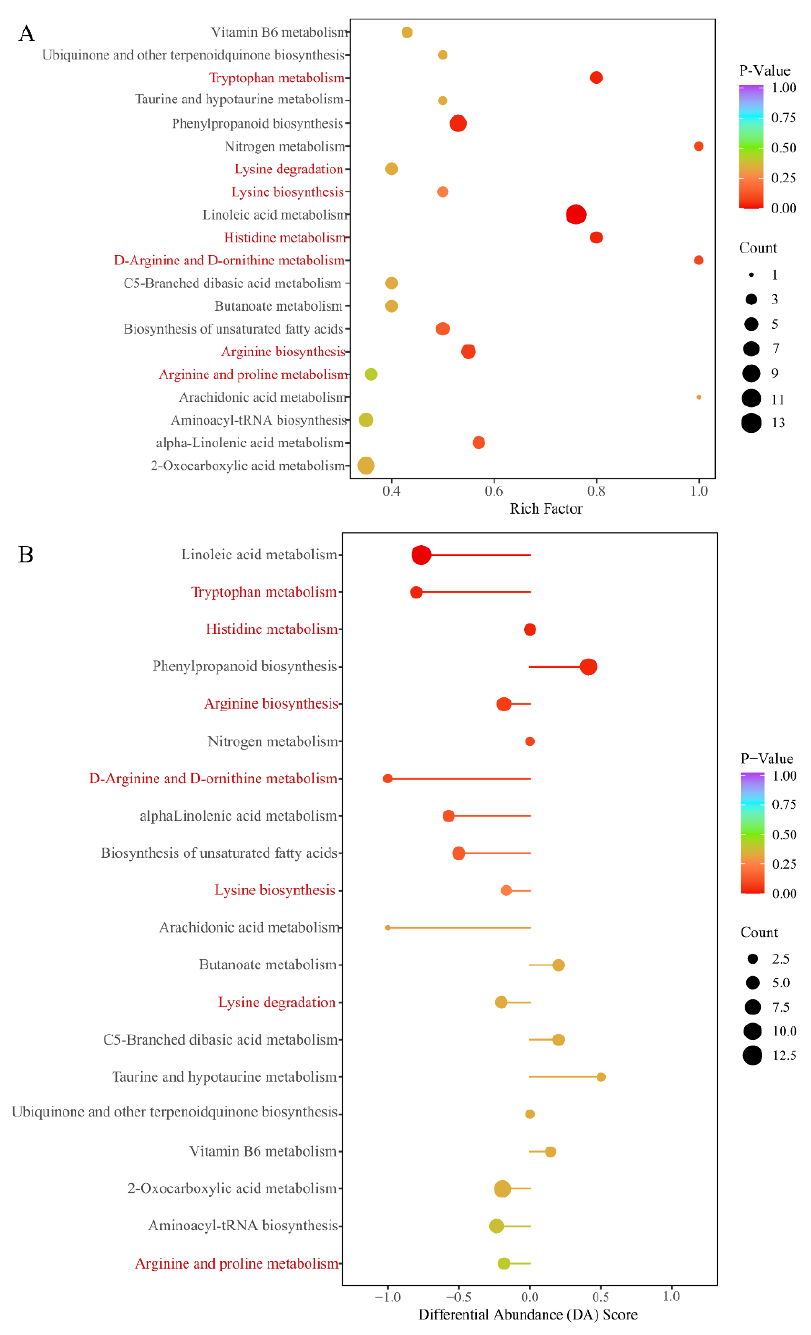
Figure 6. The main annotation results of different metabolites between ASY and SY phenotypes of F. cirrhosa . ( A ) The KEGG enrichment analysis; ( B ) differential abundance score. ASY: aberrant six-year samples. SY: six-year samples.